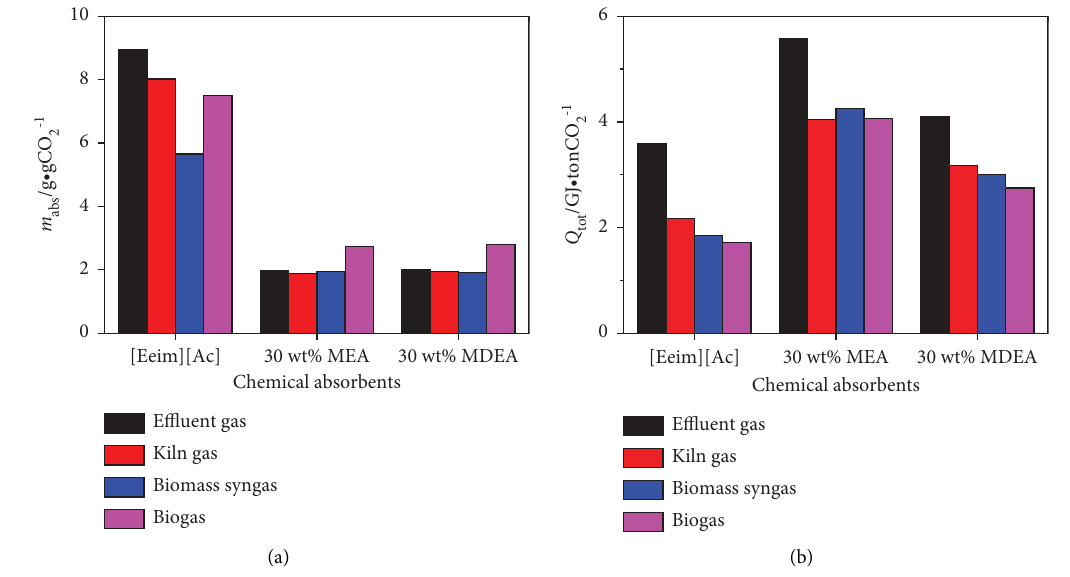
Figure 11: Te comparison of the performances of chemical absorbents for CO